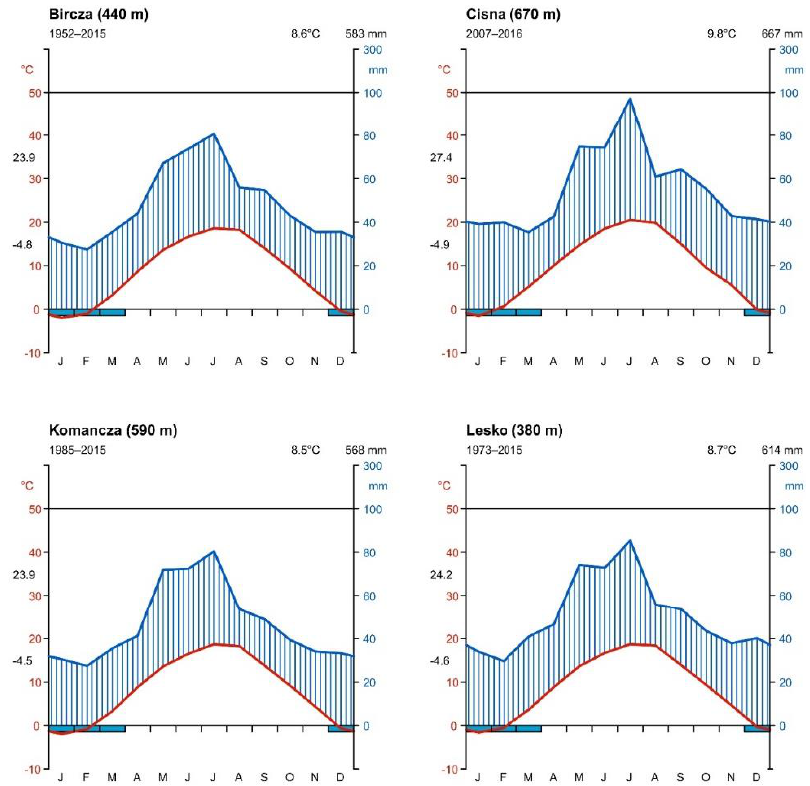
Figure 2. Climatic diagrams for experimental sites. Plots of the precipitation and temperature monthly averages, annual averages of both elements (in the upper part), and monthly averages of the daily maximum and mini- mum temperatures of the warmest and coldest months, respectively (at the left margin); rectangle under the 0 °C axis — frost likelihood (darker blue when the average daily minimum is zero or negative, lighter blue when absolute monthly minimum is zero or negative); blue vertical pattern depicts the humid months. Table 2. Mean values and coefficients of variation (CV) of tree heights and survival in 19 populations of fir at four experimental sites: BIR — Bircza, KOM —Komańcza, CIS— Cisna, LES — Lesko.